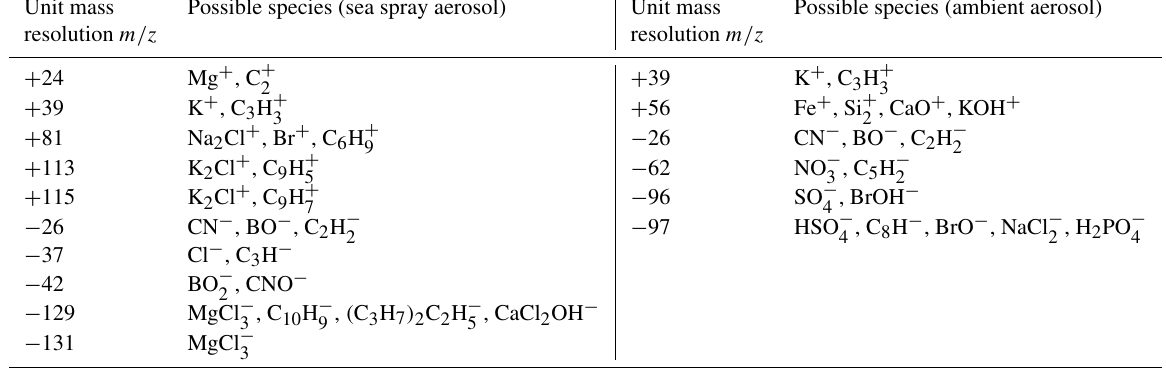
Table 1. Possible peak assignments for the m/z of reference ions for sea spray aerosol and ambient aerosol. Unit mass Possible species (sea spray aerosol) Unit mass